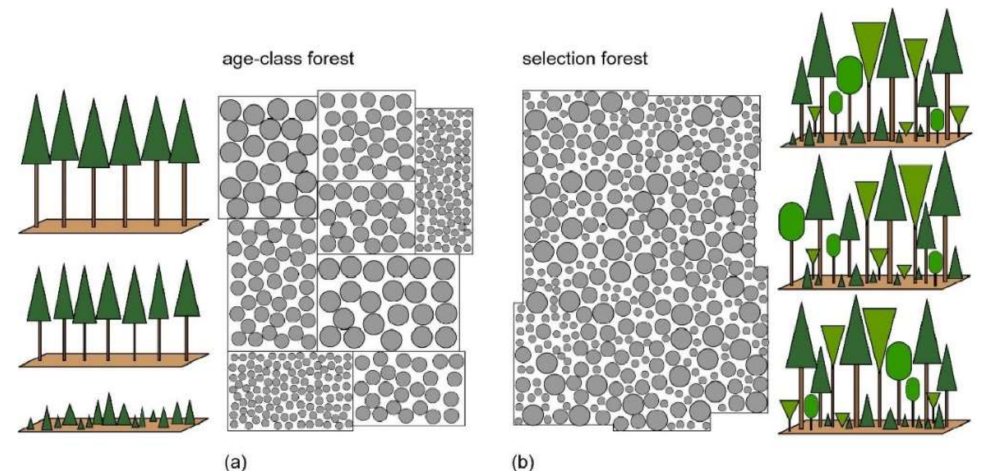
Figure 1. Stand structure in ( a ) even-aged normal forest and ( b ) selection forest. The age-class forest ( a ) consists of a spatial mosaic of stands with varying age, tree composition, and structure. The selection forest ( b ) has a wider range of species and structural diversity at the stand level, but retains a similar structure across space and time (after